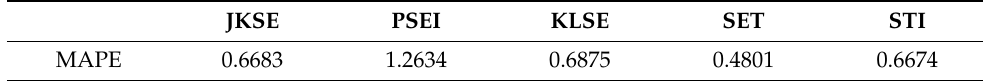
Table 8. MAPE values (%) for GBM-MCS model predictions.